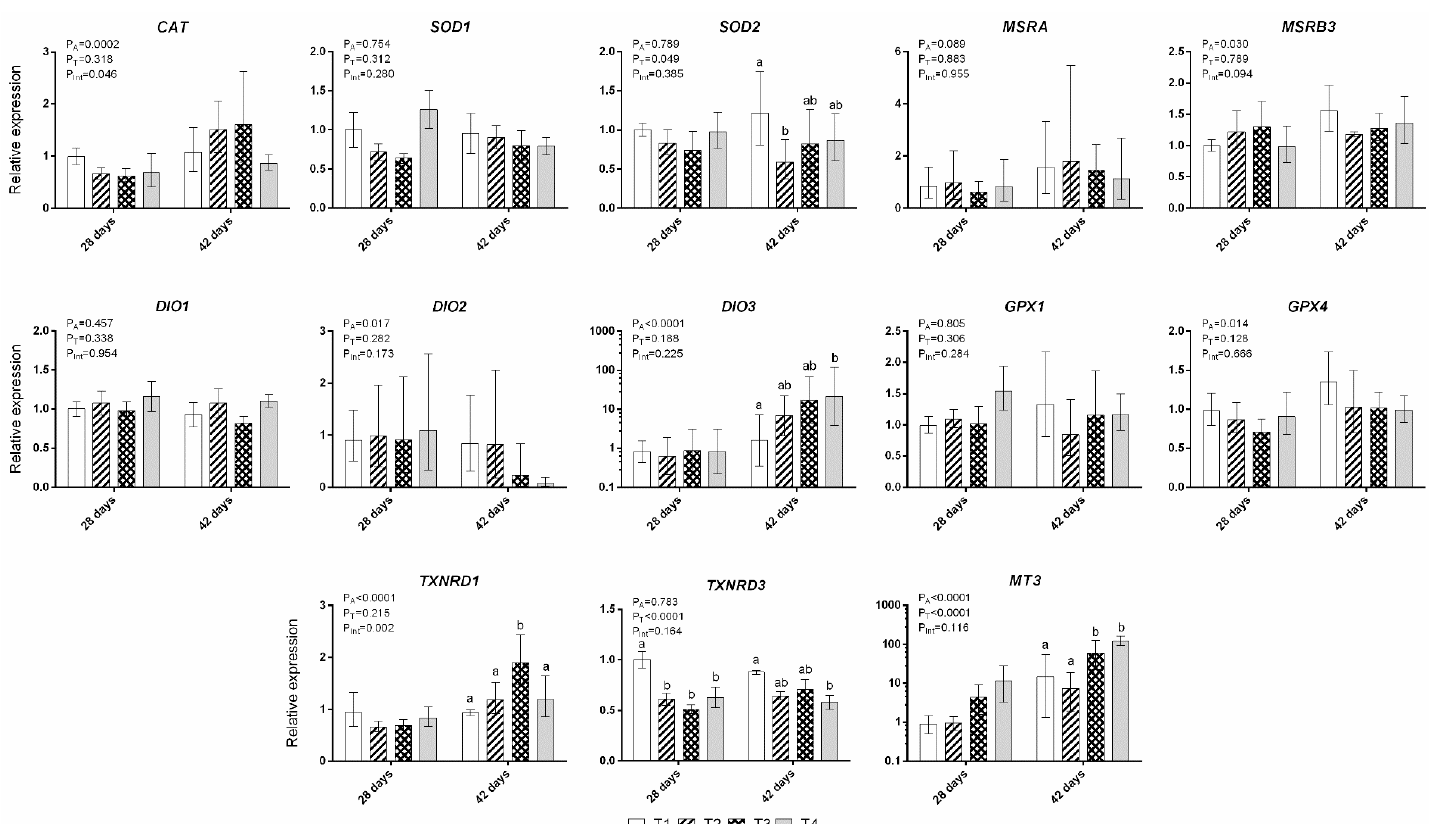
Figure 1. Relative expression levels of catalase ( CAT ), superoxide dismutase 1 ( SOD1 ) and 2 ( SOD2 ), methionine sulfoxide reductase A ( MSRA ) and B3 ( MSRB3 ), iodothyronine deiodinase 1 ( DIO1 ), 2 ( DIO2 ), and 3 ( DIO3 ), glutathione peroxidase 1 ( GPX1 ) and 4 ( GPX4 ), thioredoxin reductase 1 ( TXNRD1 ) and 3 ( TXNRD3 ), and metallothionein 3 ( MT3 ). Data for SOD1 , DIO1 , and TXNRD3 are presented as means ± standard error of the mean (SEM). Data for all other genes are presented as back-transformed means with back-transformed upper and lower confidence limits. Significances of main factor effects “age” (P A ) and “treatment” (P T ), as well as their interaction (P Int ), are reported for each variable. Columns with different superscripts within the same age differ significantly ( p < 0.05).